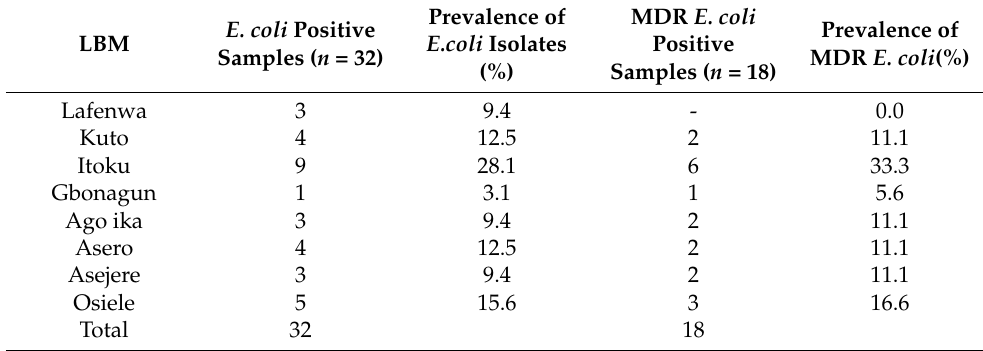
Table 4. Distribution of E. coli and multidrug resistance.